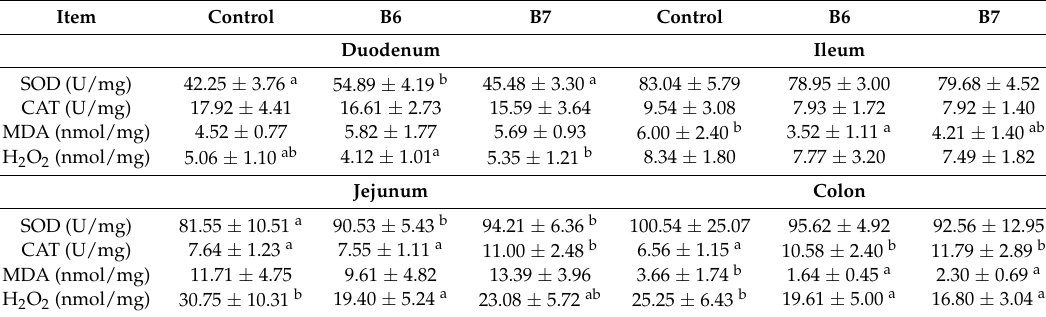
Table 4. Effects of B. coagulans on the intestinal redox status of weaned